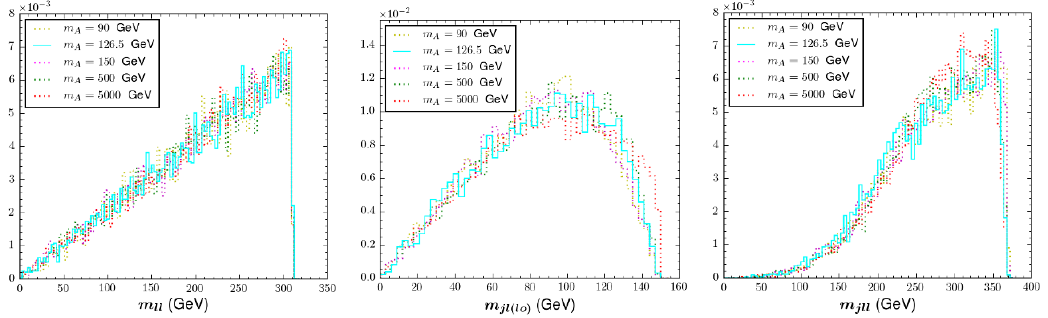
Figure 18 . The analogue of (cid:12)gure 6, but for the (cid:12)ve study points exhibited in table 2. The distributions are color-coded according to our color conventions for the regions in (cid:12)gure